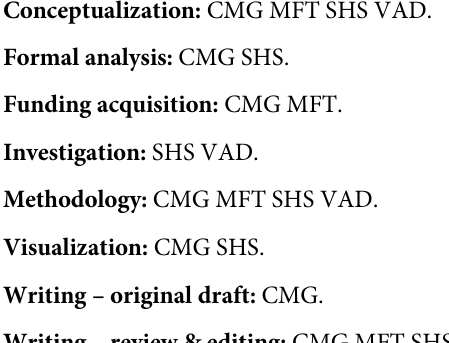
S1 Table. Proteins co-purifying with Sup35 in wild-type and tsa1 tsa2 mutant strains. Sup35-TAP was immunoprecipitated from the wild-type and tsa1 tsa2 mutant strains and the associated proteins identified from three repeat experiments using mass spectrometry. This resulted in the identification of 63 and 47 proteins which are shown according to whether they were identified in the wild-type, tsa1 tsa2 mutant or both strains. S2 Table. Functional categorisation of Sup35-associated proteins. The proteins identified within each MIPS category classification shown in Fig 1A are